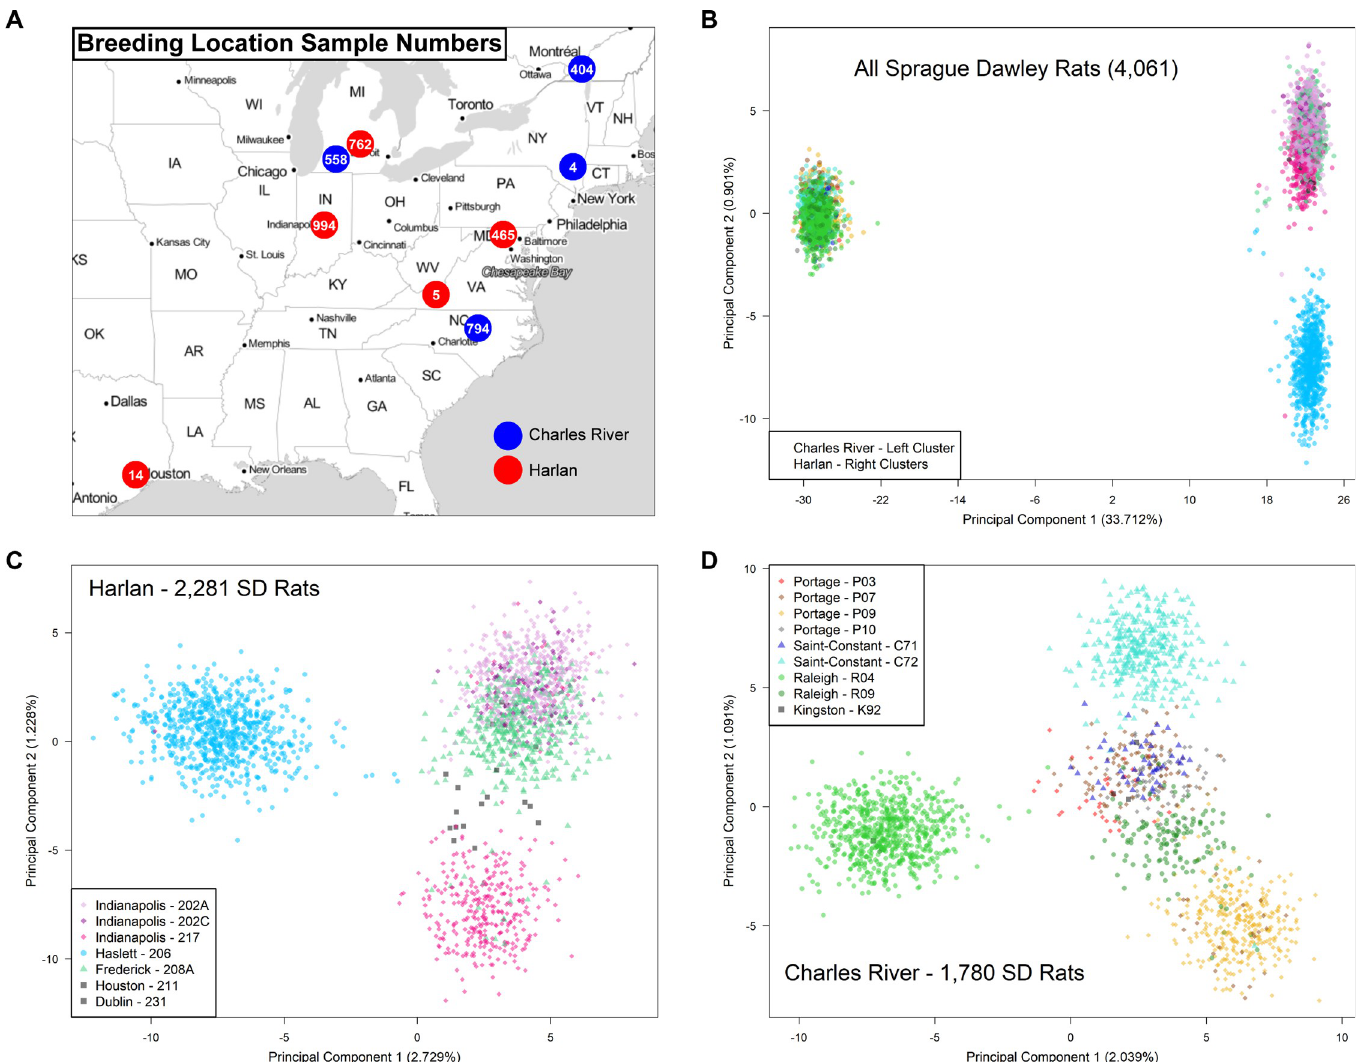
Fig 2. Genetic architecture of SD rats from Charles River vs. Harlan. (A) Map of the nine vendor breeding locations and the number of SD rats obtained from each location. Map tiles by Stamen Design, under CC BY 3.0. Data by OpenStreetMap, under ODbL. (B) A summary of the genetic data from all 4,061 SD rats based on principal components 1 and 2 from PCA. Each point represents a sample. The left cluster is composed of samples from Charles River and the right clusters are composed of samples from Harlan. (C-D) Repeated PCA analyses on subsets of the samples from Harlan and Charles River, colored by barrier facility of